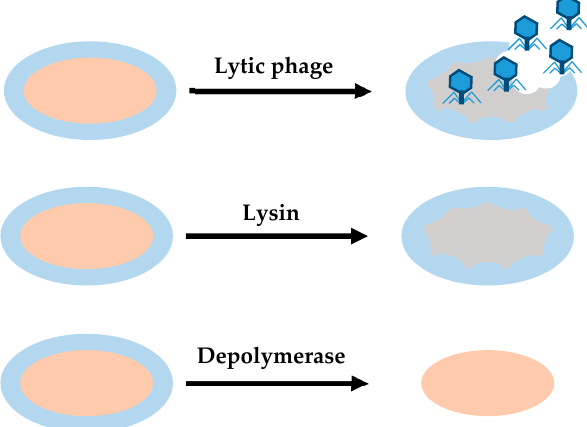
Figure 3. Differences between the action of lytic phages, lysins and depolymerases. Lytic phages provide antibacterial effect, degrading cell wall and EPS. Lysins provide a bactericidal effect, disrupting cell walls when they establish contact with their target. Depolymerases degrade EPS.